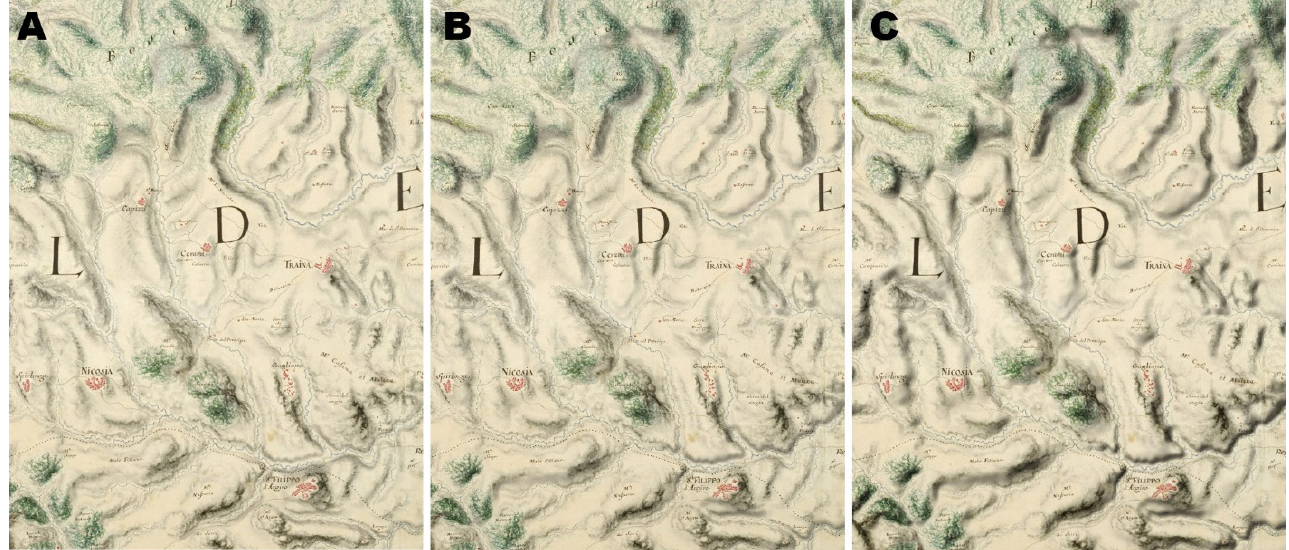
Figure 7. Three contrast values (Map of Sicily): ( A ): 20, ( B ): 40, and ( C ): 100.